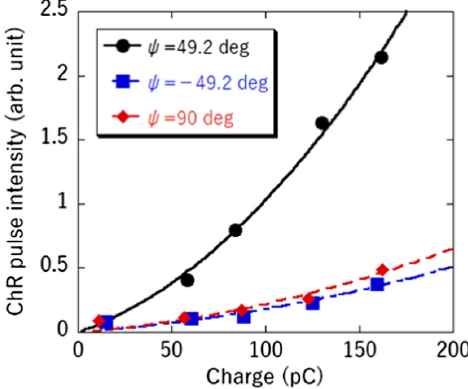
FIG. 6. THz intensity versus charge at various tilt angles. The THz intensity increases proportionally to the square of the charge at ψ ¼ 49 . 2 ° and to the charge itself at Ψ ¼ 49 . 2 ° and 90°.